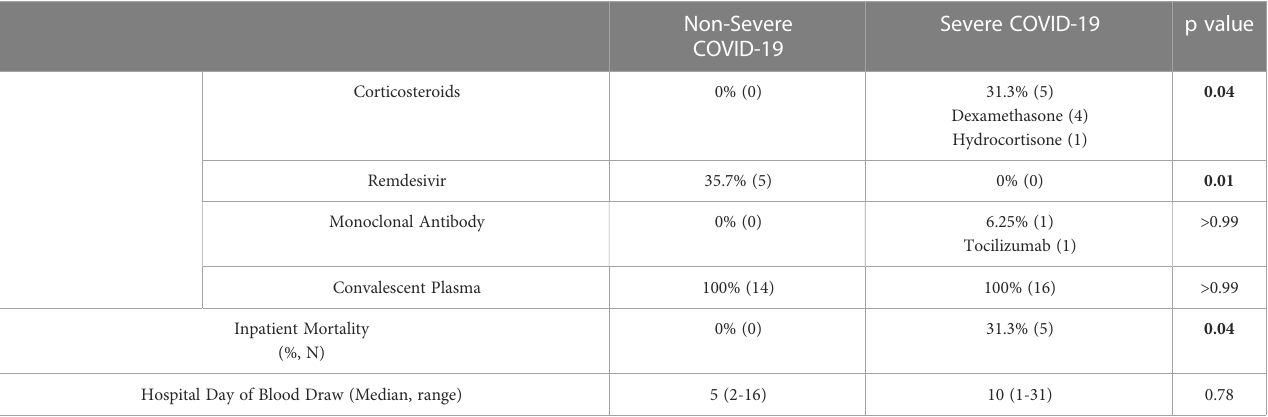
antibodyforN(84.6%reactive).Inthenon-severegroup,themajorityof patientsexhibitedpositiveIgGantibodytoRBDandN,althoughatlower